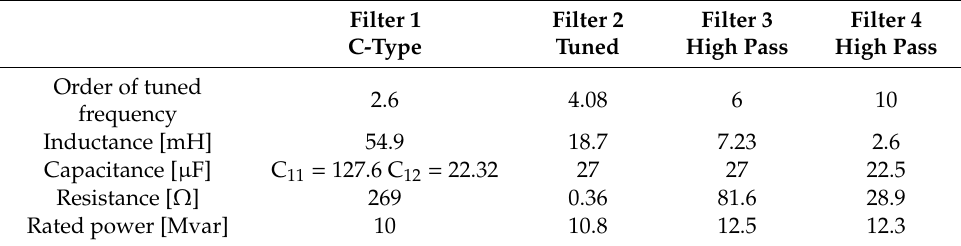
Table 2. Characteristics of filter branches.